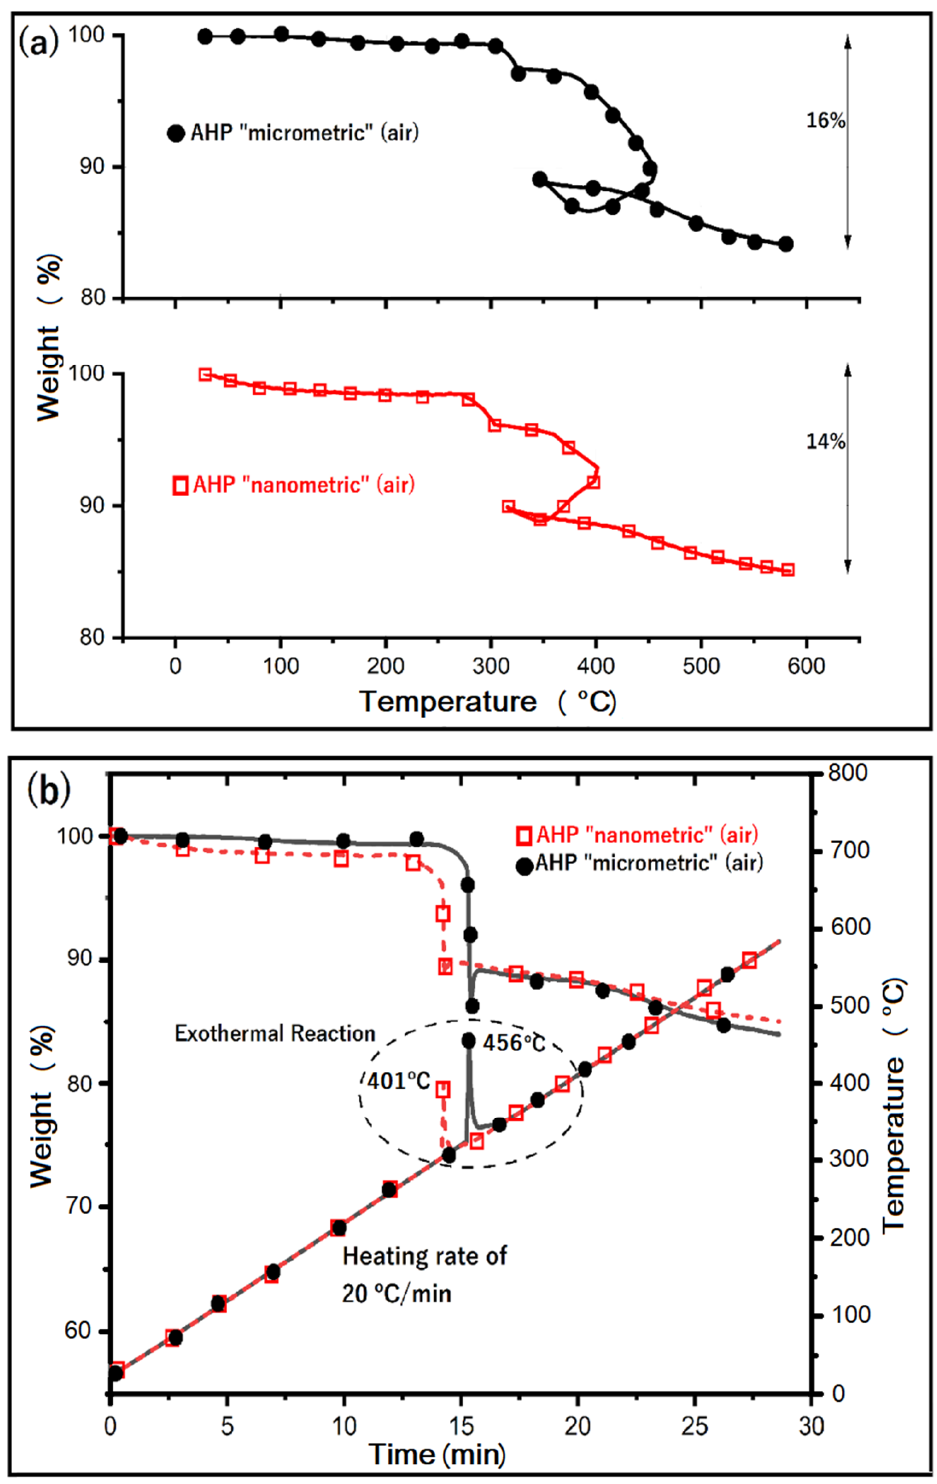
Figure 3. ( a , b ). Comparative TGA of AHP microparticles and NPs under air: ( a ) evolution of the weight function of temperature; ( b ) evolution of the weight and measured temperature during the time of heating (heating rate: 20 °C/min).